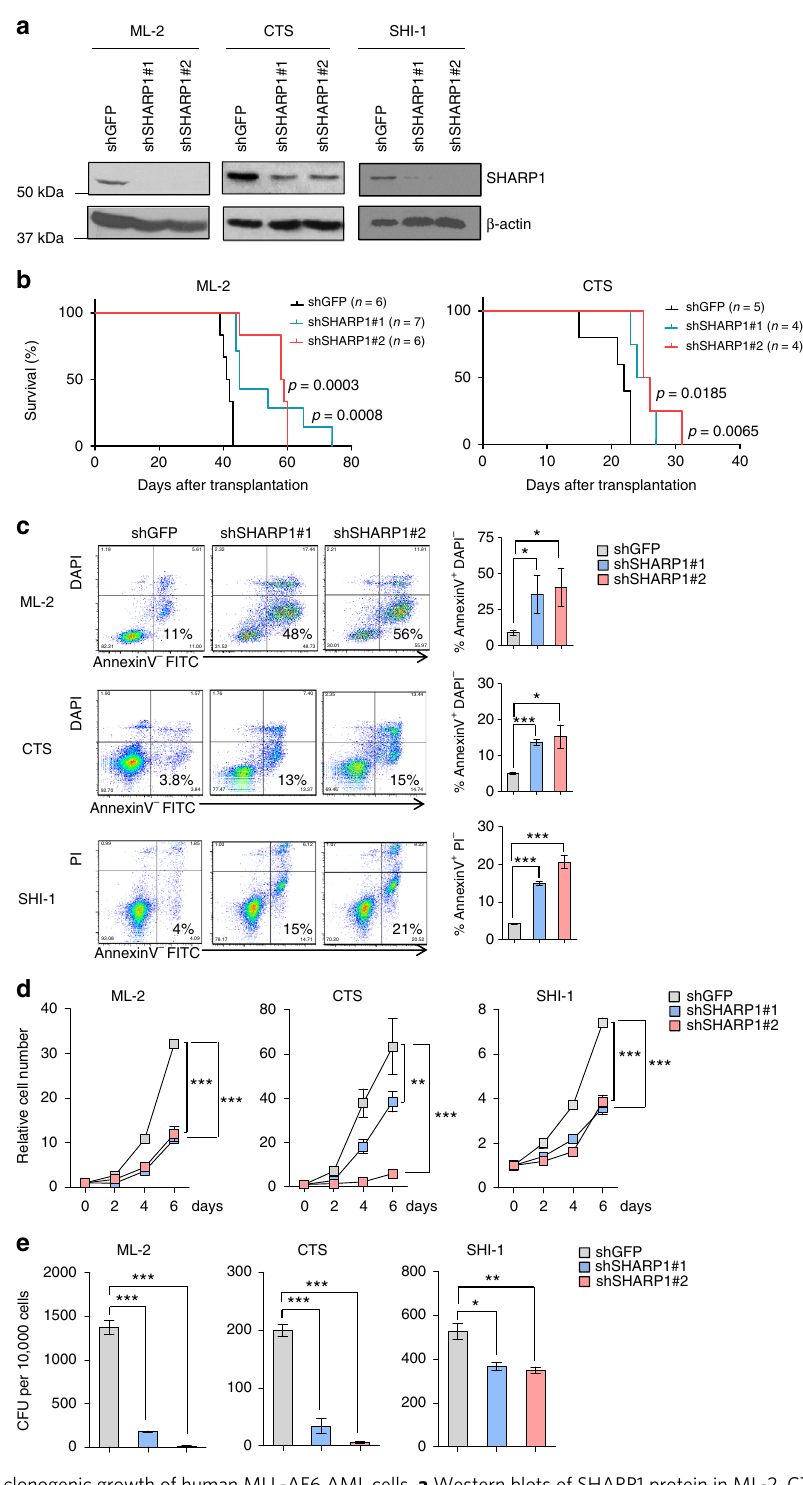
Fig. 3 SHARP1 is crucial for clonogenic growth of human MLL-AF6 AML cells. a Western blots of SHARP1 protein in ML-2, CTS and SHI-1 cells transduced with the indicated shRNAs. Western blots are representative of at least three independent experiments. b Kaplan – Meyer survival curve of sublethally irradiated recipient NSG mice transplanted with 5 × 10 4 ML-2 or 1 × 10 5 CTS cells transduced with the indicated shRNAs. P values are determined by the Log-rank (Mantle-Cox) Test. c Left panel: Representative fl ow cytometry plot of ML-2, CTS, and SHI-1 cells transduced with the indicated shRNAs for AnnexinV and DAPI or PI. Right panel: Percentage of AnnexinV + and DAPI − or PI − cell are shown. d Cell count of ML-2, CTS, and SHI-1 cells transduced with the indicated shRNAs in culture. The value is determined as fold increase in cell number relative to the number of cells initially plated. e Colony- forming units (CFU) of ML-2, CTS, and SHI-1 cells transduced with the indicated shRNAs. The number of colonies observed 7 days after the plating. The graphs are representative examples of three independent experiments and presented as mean ± s.e.m, * p < 0.05, ** p < 0.01, *** p <